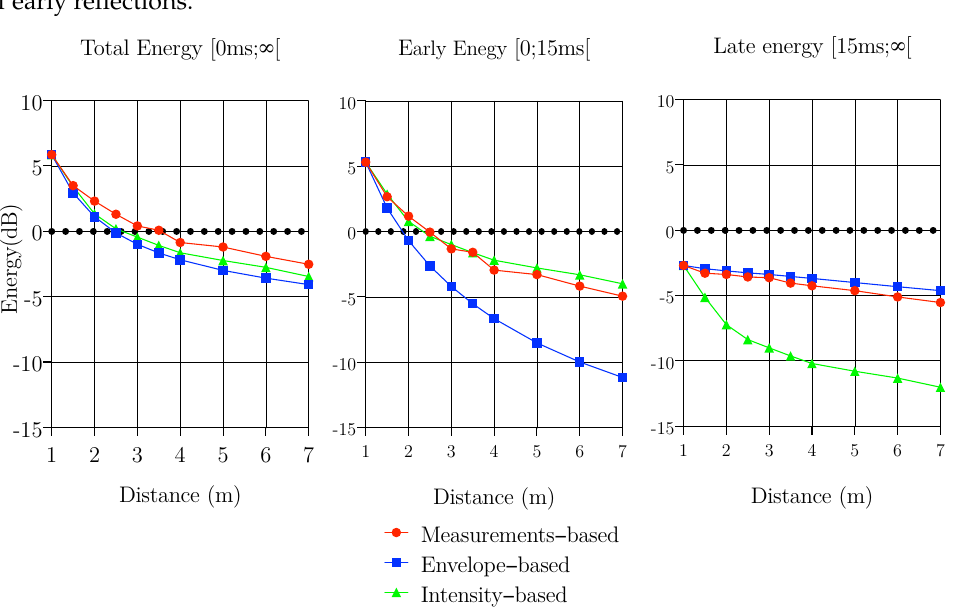
Figure 1. Evolution of the total energy E tot ( left ), the early energy E s ( middle ), and reverberation E rev ( right ) according to the source distance for the BRIRs generated by the two models and for the measured